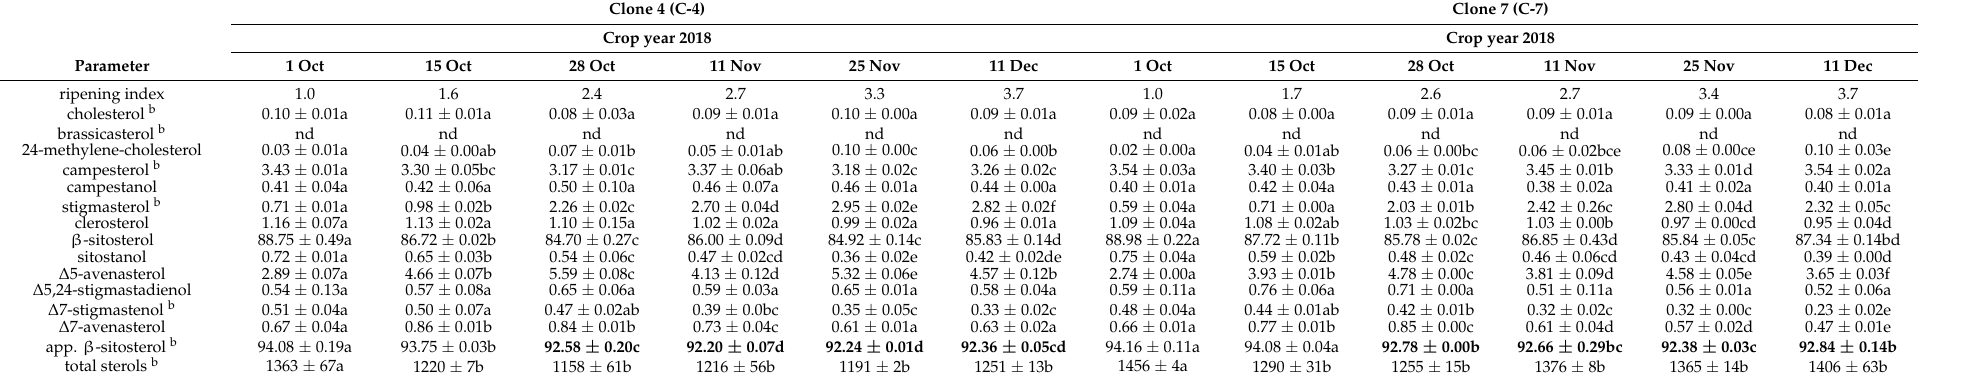
Values are mean ± standard deviation ( n = 2). a Different letters for each parameter indicate significant statistical differences ( p < 0.05) among picking dates for each crop year (a–f). b Limits established by the current regulation: total sterols ≥ 1000 mg/kg; cholesterol ≤ 0.5%; brassicasterol ≤ 0.1%; campesterol ≤ 4.0%; stigmasterol ≤ campesterol; ∆ 7-stigmastenol ≤ 0.5%; app. β -sitosterol ≥ 93.0%. Values in bold: non-compliance. Not detected =